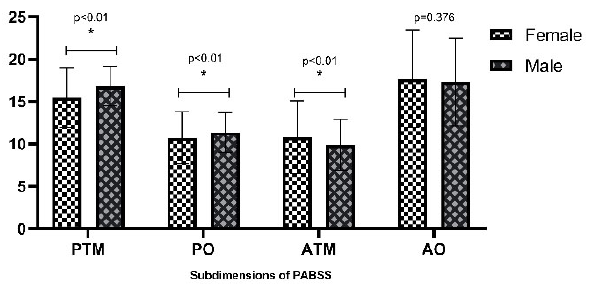
Fig. 1. Comparisons of PABSS’ subdimensions between fe- male and male football players . Values are expressed as a mean and standard deviation; * p < 0.01. p values, 95% confidence in- terval; PTM, Prosocial teammate; PO, Prosocial opponent; ATM, Antisocial teammate; AO, Antisocial